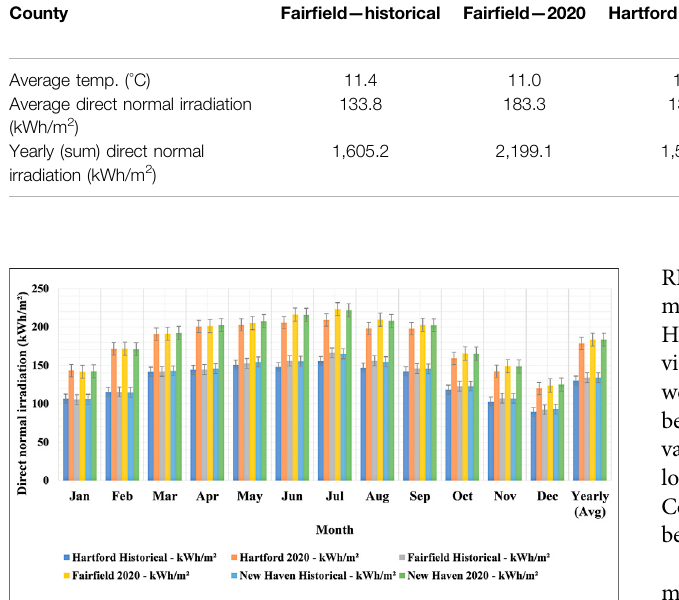
Frontiers in Built Environment |